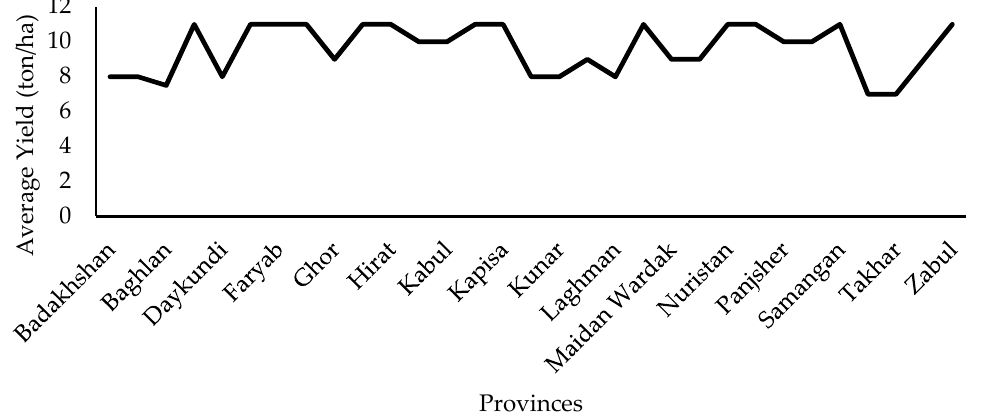
Figure 6. Average yield of table grapes (ton/ha) in Afghanistan during